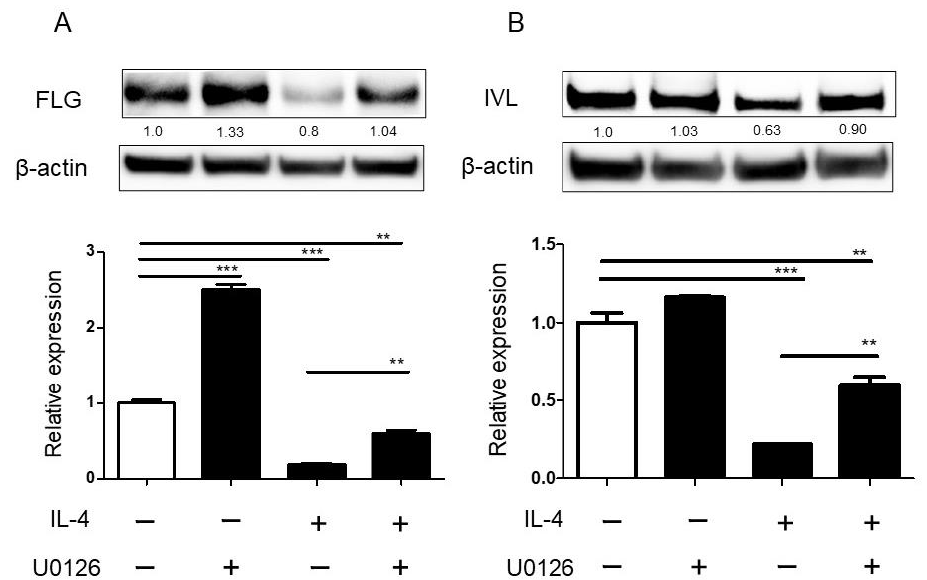
Figure 5. ERK inhibitor restored the reduction in the expression levels of filaggrin and involucrin in NHEK. NHEKs were treated with IL-4 (20 ng/mL) in the presence or absence of ERK inhibitor (1 µM) for 72 h (FLG) or 48 h (IVL) for qRT-PCR and for 96 h (FLG) or 72 h (IVL) for Western blotting analyses. FLG ( A ) and IVL ( B ) mRNA expression was analyzed by qRT-PCR. FLG ( A ) and IVL ( B ) protein expression was analyzed by Western blotting. All data are presented as mean ± S.E.M. (n = 3 per each group). ** p < 0.005, *** p < 0.001 one-way analysis of variance followed by Bonferroni’s multiple comparison test.